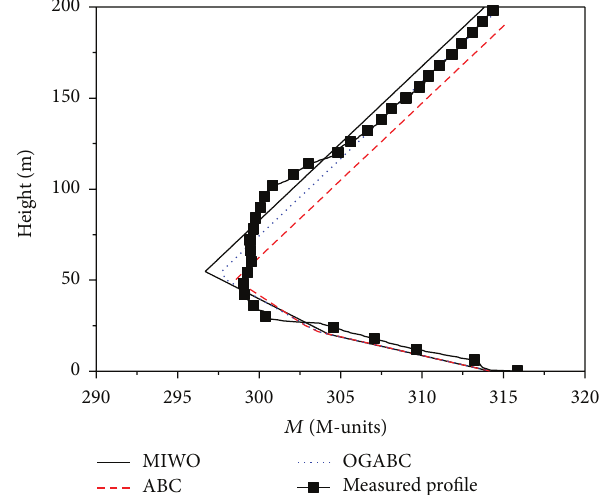
Figure 8: The comparison of the inverted profile with the measured